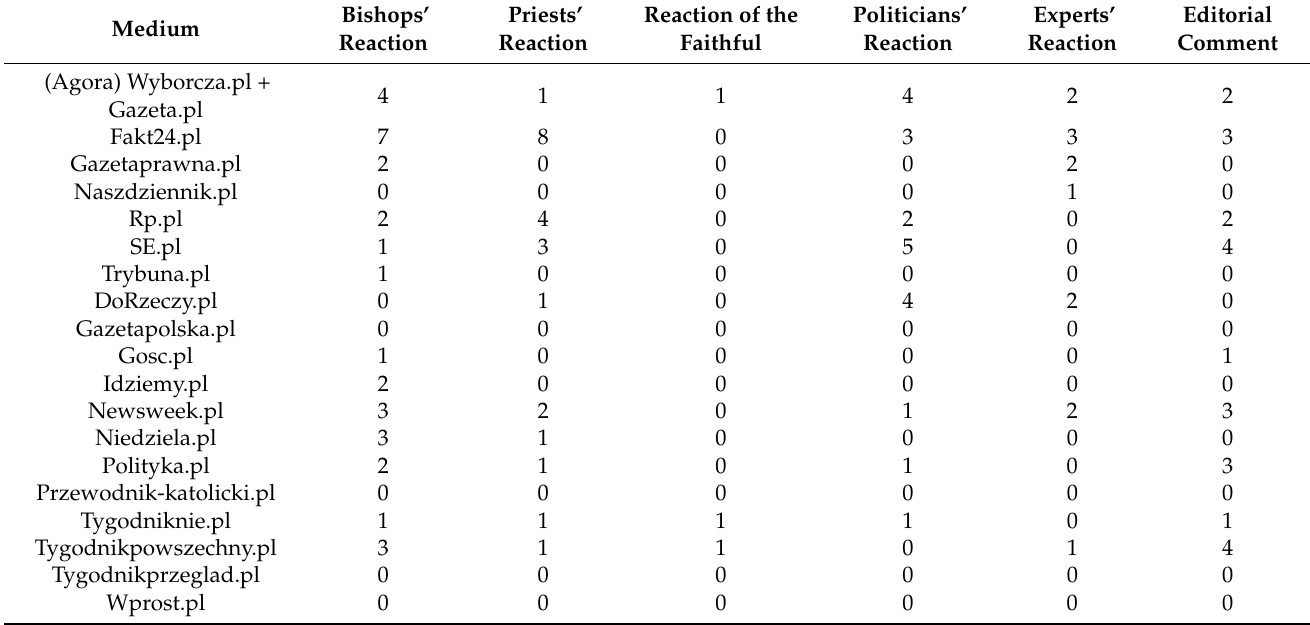
Bishops’ Priests’ Reaction of the Politicians’ Experts’ Editorial Reaction Reaction Faithful Reaction Reaction Comment